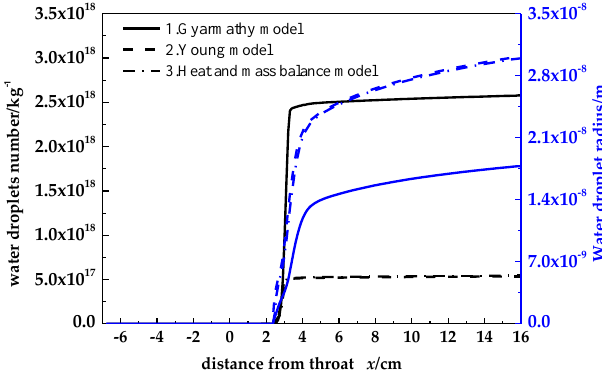
Figure 9. Droplet number and radius distribution along the nozzle axis.